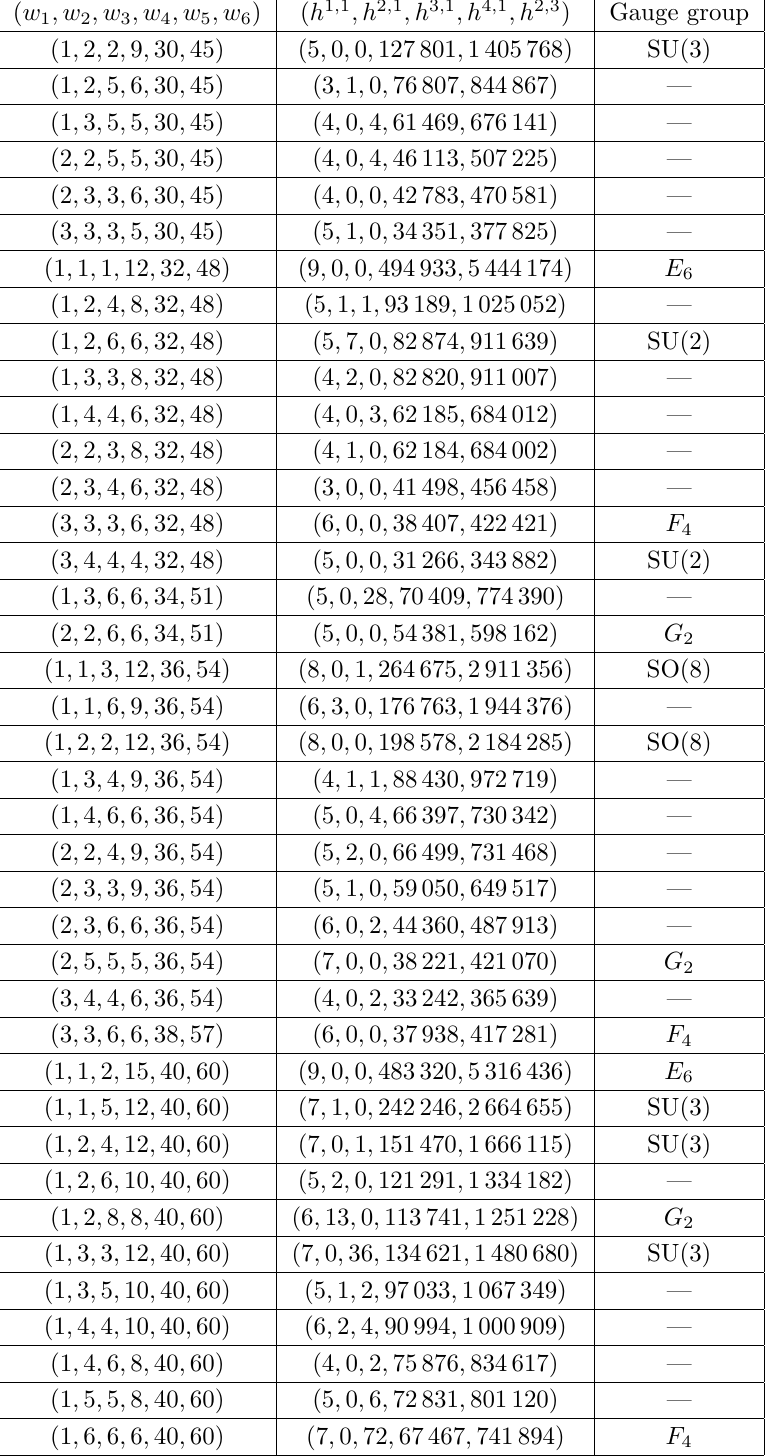
Table 10 . A list of elliptic CY5 hypersurfaces in weighted projective spaces P 1 ,w 1 ,w 2 ,w 3 ,w 4 ,w 5 ,w 6